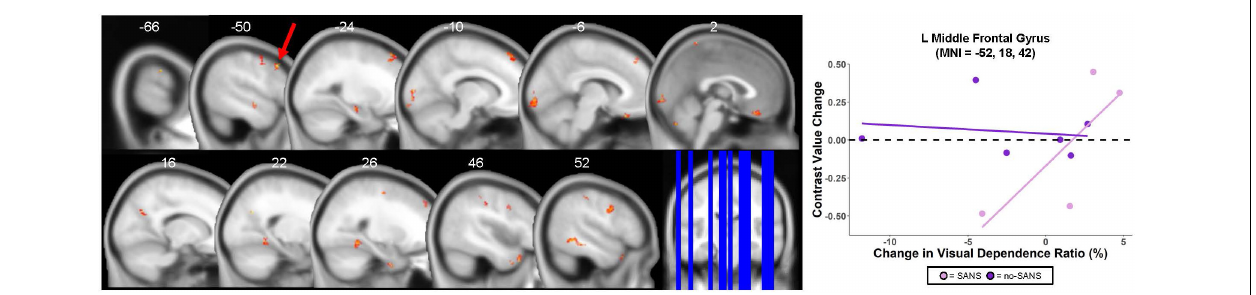
FIGURE 8 | SANS vs. No-SANS Group Differences. Left: regions in which HDBR + CO 2 participants who developed signs of Spaceflight-Associated Neuroccular Syndrome (SANS) showed a stronger correlation between pre- to post- change in brain activity during vestibular stimulation and pre- to post- change in balance ratio compared to those who did not develop signs of SANS (no-SANS). Balance ratio was calculated as: (balance—eyes open score/balance—eyes closed score) ∗ 100. Results overlaid onto MNI standard template; non-parametric p < 0.0005, k = 10. One of the five SANS subjects was excluded from analysis here due to outlier values for their eyes closed balance score; thus n = 4 for the SANS group and n = 6 for the no-SANS group. Right: correlation between brain changes and visual dependence balance ratio change for an example cluster; SANS subjects are shown in pink, no-SANS subjects are shown in purple. Regression lines are shown for each group for reference only and do not represent the results of any statistical